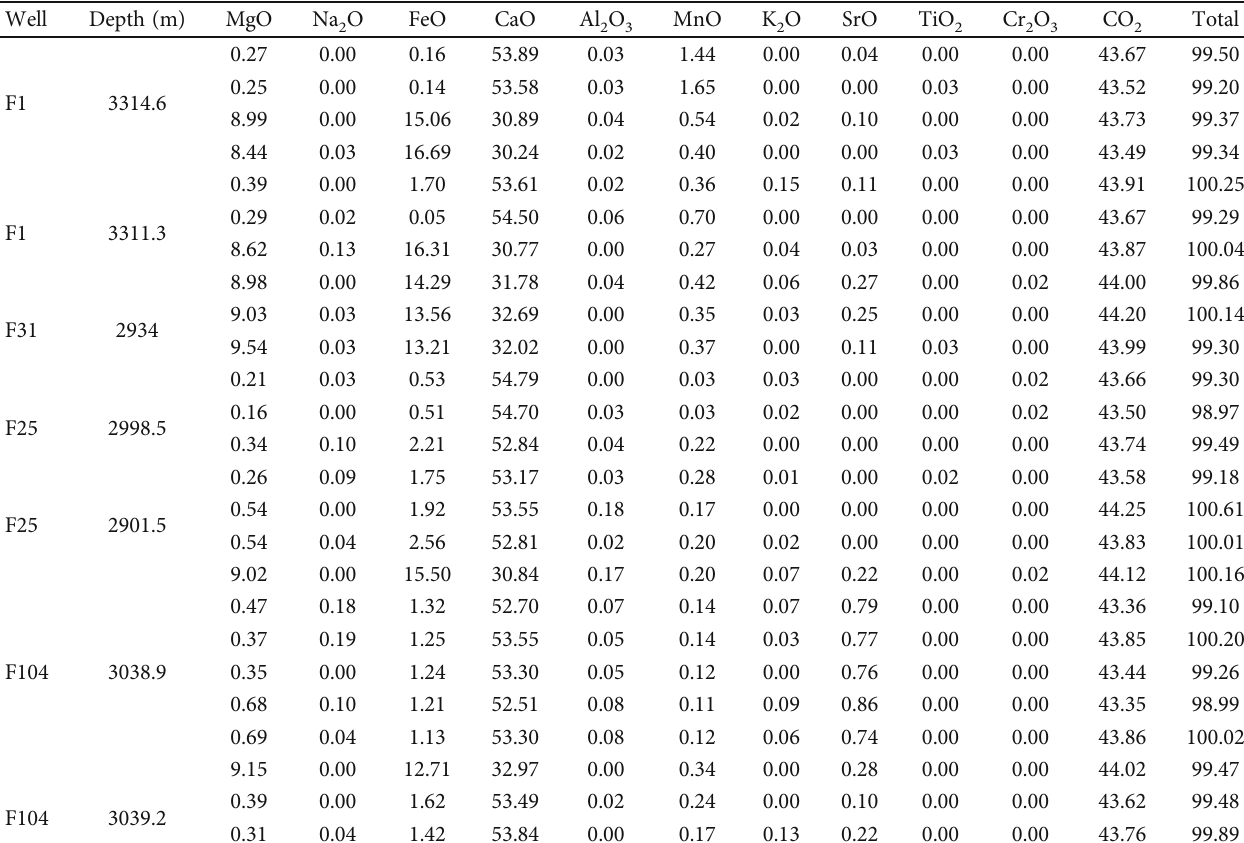
Table 5: Electronic probe microanalysis for carbonate cements in the sandstone